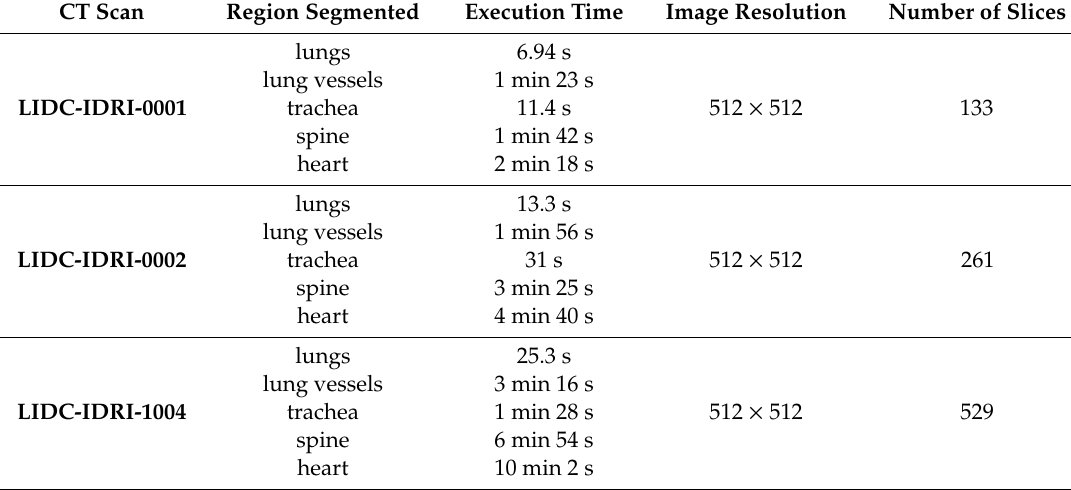
Table 1. Execution times for di ff erent anatomical structures, including segmentation, reconstruction, and results